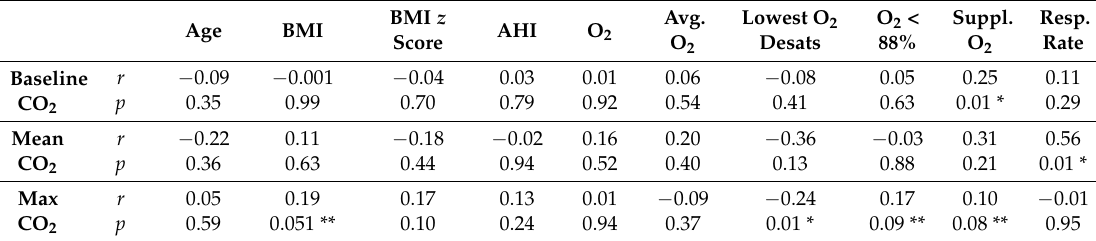
Table 5. Correlation between Ventilation Parameters and CO 2